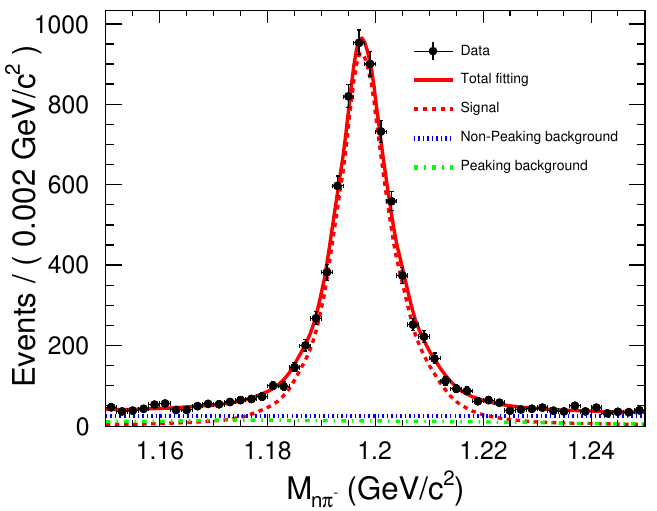
Figure 1 . The distribution of M for the process ψ (3686) → n ¯ nπ + π − ( X ) . The black dots with nπ − error bars are the data, the red solid line is the total fit function, the red dashed line is the signal function, the blue dotted line is the non-peaking background function, and the green dash-dotted line is the peaking background function.